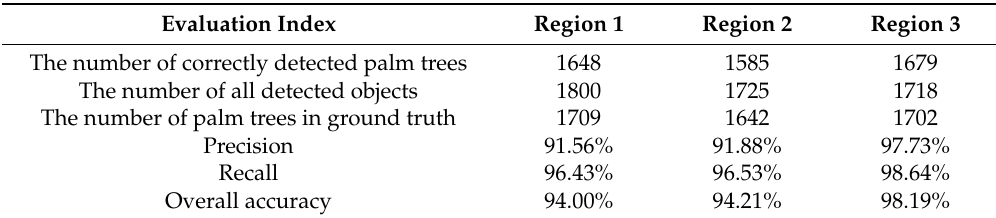
Table 2. Detection results of artificial neural network (ANN).